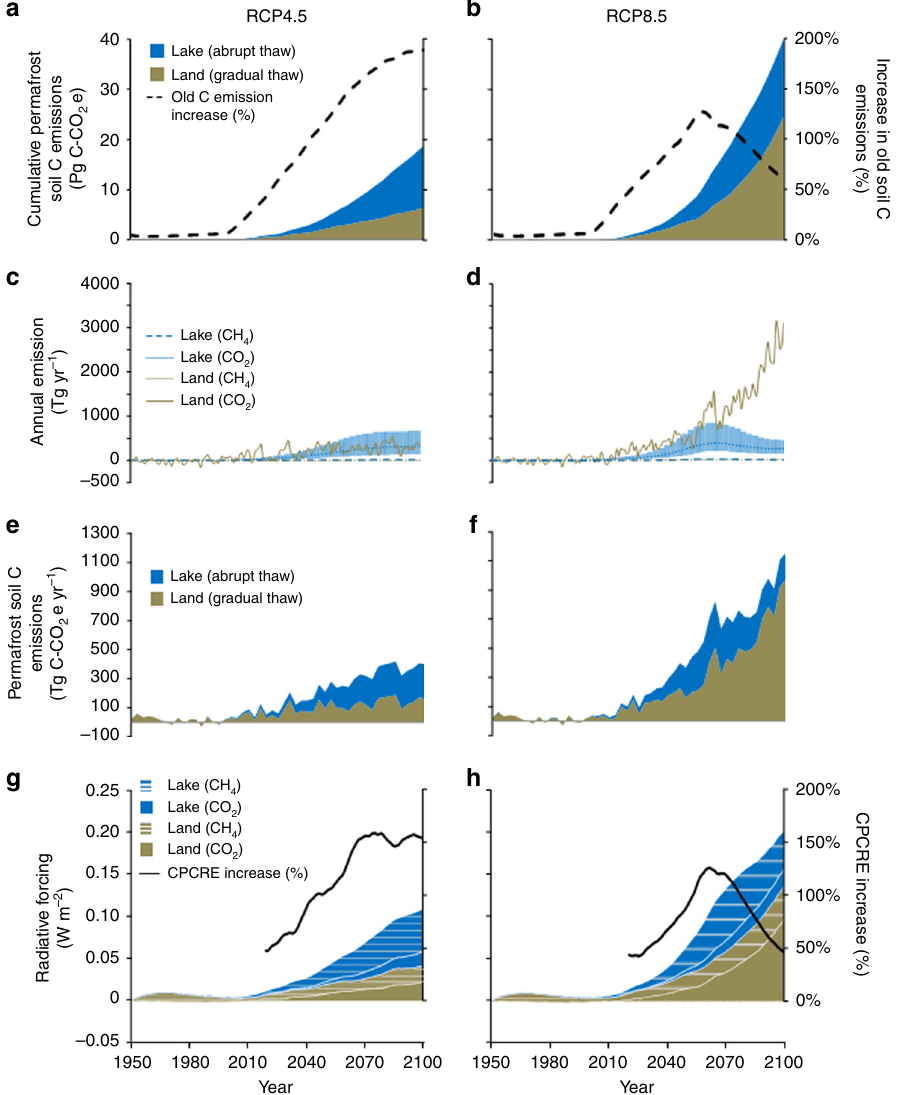
Fig. 4 Circumpolar permafrost carbon emissions from gradual thaw (land) versus abrupt thaw (lakes) from 1950 to 2100. Permafrost soil carbon emissions, modeled according to representative concentration pathway (RCP) 4.5 and 8.5 scenarios, are distinguished for homogenous gradual thaw from CLM4.5BGC (brown) and heterogeneous abrupt thaw by AThaw thermokarst-lake formation (median values, blue). Cumulative emissions, including percent increase in emissions from old permafrost carbon by abrupt thaw ( a , b ). Annual CH 4 and CO 2 emissions expressed individually as Tg yr − 1 ( c , d ) and collectively as Tg C-CO − 1 ( e , f ) based on a GWP 12 ) and units conversions shown in Supplementary Table 2. Error 2 e yr 100 of 28 (ref. bars ( c , d ) surrounding the median lake emissions are the 68% uncertainty range from a 500 member AThaw model ensemble. Radiative forcing ( g , h ) associated with fl uxes in c and d . In g and h , the increase in circumpolar permafrost-carbon radiative effect (CPCRE) attributed to abrupt thaw lakes is shown only for years 2018 – 2100, when the AThaw modeled carbon release exceeds one standard deviation in simulated CLM permafrost carbon fl uxes during the 1950 – 2017 reference